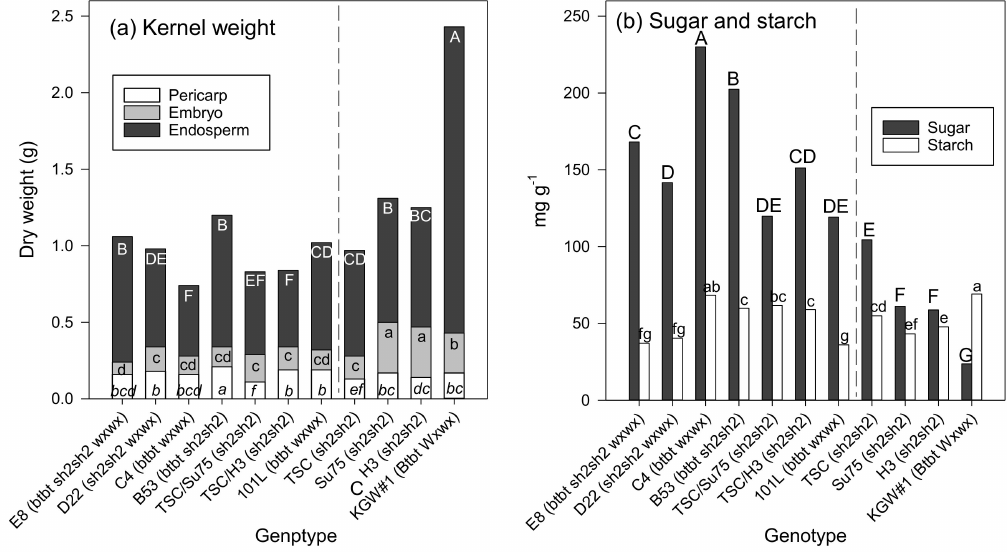
Figure 2. ( a ) Dry weight of pericarp, embryo and endosperm and ( b ) sugar content and starch content of 11 corn genotypes. Means for the same trait with the same letter are not significantly different at 0.01 probability level determined by